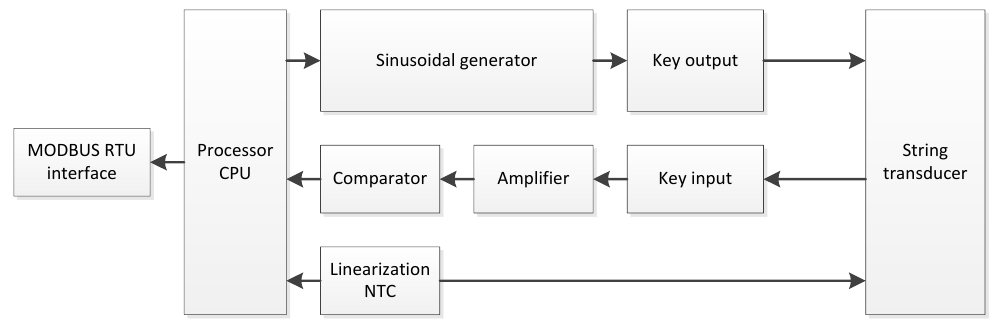
Figure 5. Block diagram of measuring system based on vibrating wire strain gauge.